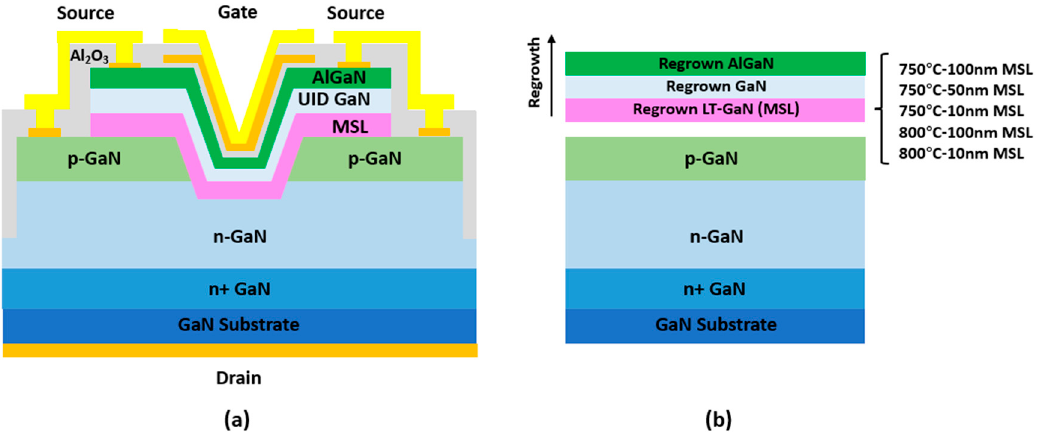
Figure 1. Schematic of ( a ) the GaN trench CAVET used for the device fabrication and ( b ) epitaxial thin film layers with LT-GaN MSLs. LT-GaNs were regrown with different MOCVD growth temperatures and thicknesses.